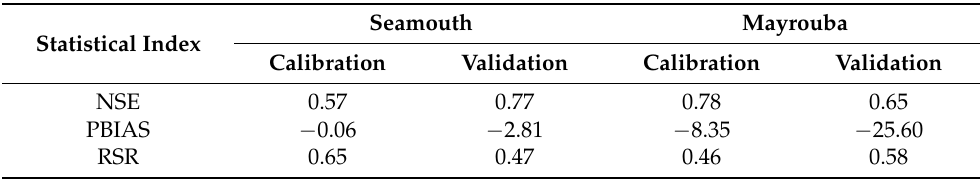
Table 8. Monthly flow calibration and validation statistics of the measured and simulated data at F1 and F2